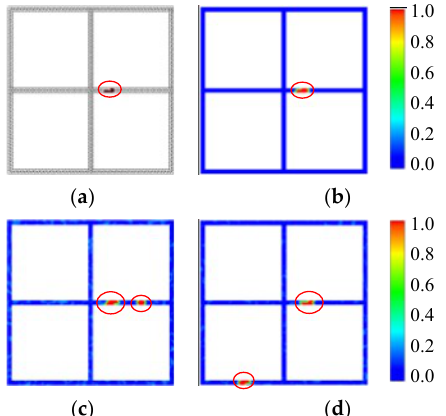
Figure 7. The imaging result of corrosion diagnosis on 2 × 2 block. ( a ) One corrosion fault setting; ( b ) One corrosion fault; ( c ) Two corrosion faults in one branch; ( d ) Two corrosion faults in two